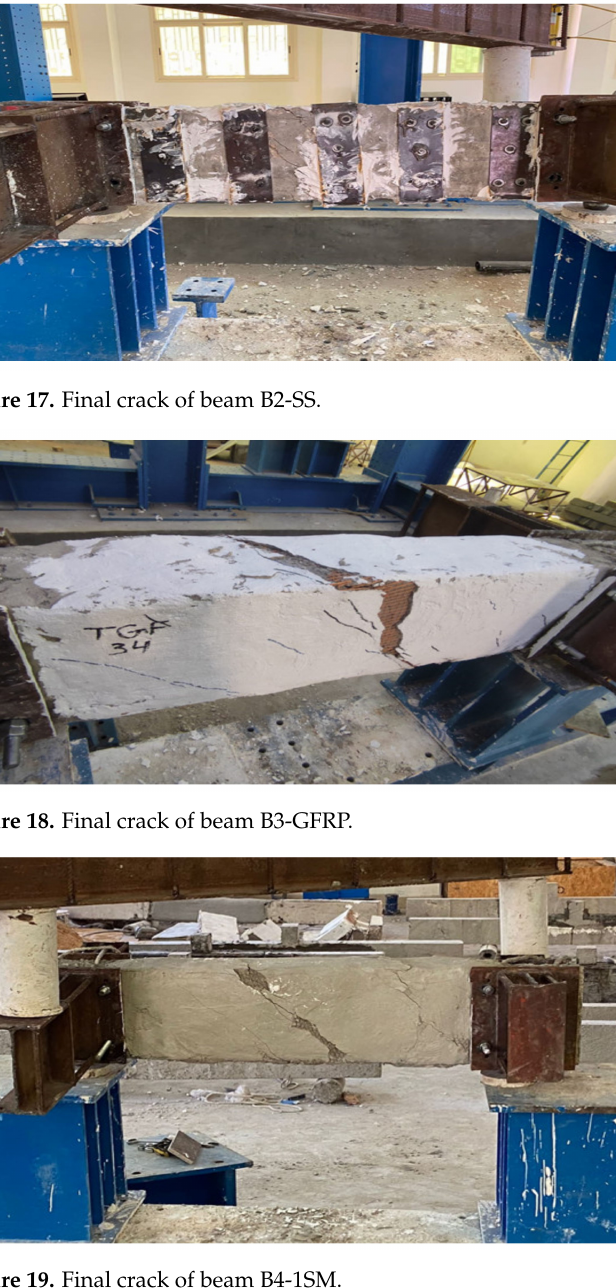
Figure 19. Final crack of beam